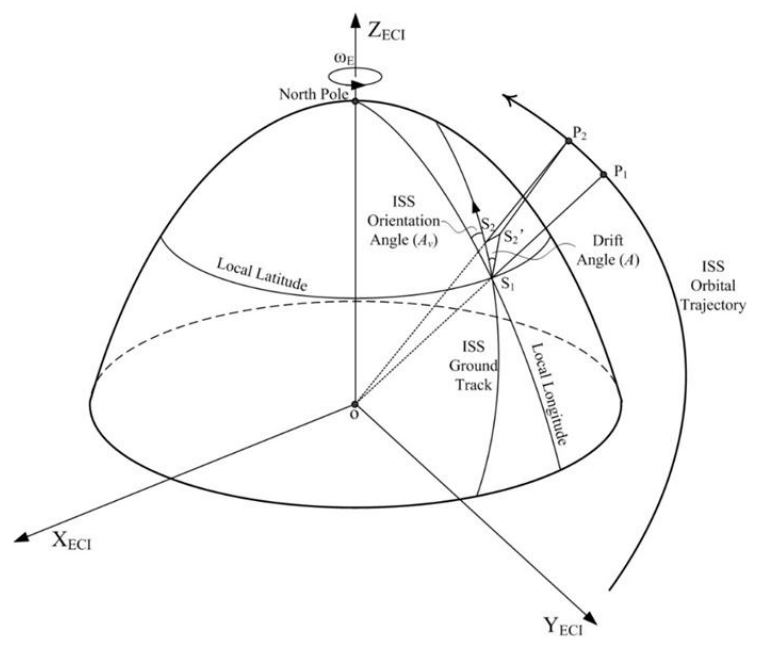
Figure 3. Illustration of the drift angle in an Earth Centered Inertial (ECI) coordinate system. The angle formed by and is the drift angle, and that formed by and the local longitude is the ISS orientation angle ( A ). The ECI reference frame has its origin v at the mass center of the Earth, its Z-axes aligns with the Earth’s spin axis toward the North Pole, The X-axis is permanently fixed in a direction relative to the celestial sphere, and Y-axes is defined by right hand